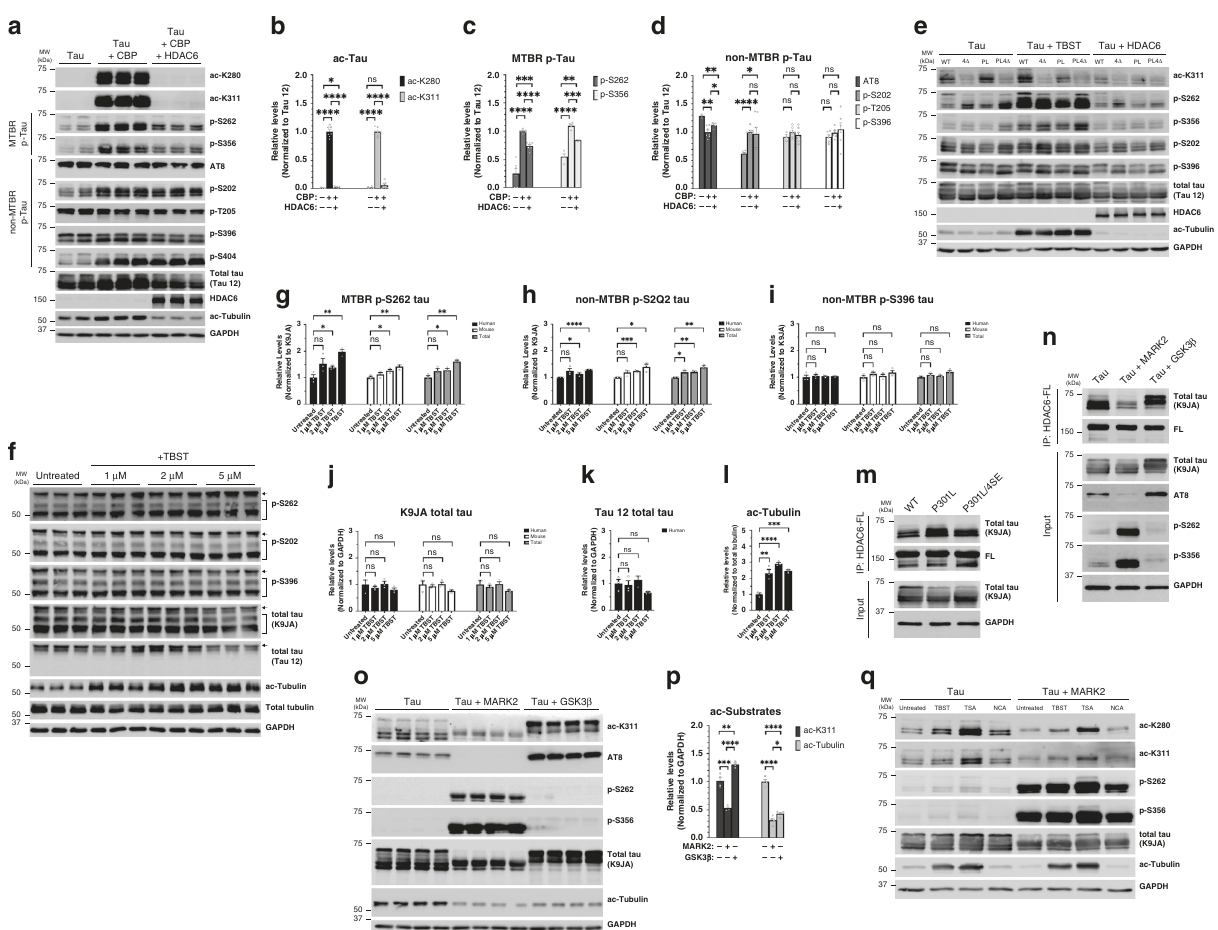
Fig. 4 The targeting of tau by HDAC6 is regulated by tau kinases. a Immunoblotting of HEK-293A cells cotransfected for 48 h with WT tau, the acetyltransferase CBP, and WT HDAC6 (where indicated) using acetylation or phosphorylation speci fi c tau antibodies. b – d The relative levels of modi fi ed tau within the MTBR (ac-280, ac-K311, p-S262, and p-S356) or outside the MTBR (AT8, p-S202, p-T205, and p-S396) were quanti fi ed by densitometry of tau PTMs normalized to total tau (Tau 12). e Cells expressing the indicated tau constructs (WT, 4 Δ , PL, and PL4 Δ ) were treated with tubastatin A (TBST) to inhibit HDAC6 or cotransfected with WT HDAC6 to suppress tau acetylation followed by immunoblotting with acetylation or phosphorylation speci fi c tau antibodies as in a . f – l Primary cortical neurons (E16) from PS19 derived tau-transgenic mice cultured for ten DIV were treated overnight with TBST at a concentration of 1 – 5 μ M and analyzed by immunoblotting followed by quanti fi cation by densitometry of tau PTMs normalized to human, mouse, or total tau (K9JA). The arrows in f highlight overexpressed human tau migrating at ~65 kDa compared to mouse tau at ~50 kDa (see also Supplementary Fig. 6c to distinguish between human and mouse tau). m Co-IP assay evaluating HDAC6 binding to WT tau, tau-P301L, and tau-P301L/4SE mutant containing S → E substitutions at all four MARK2-targeted phosphorylation sites (S262/S290/S324/S356E). Despite P301L tau showing greater binding to HDAC6, the addition of the MARK2 phosphorylation-mimic mutations reduced HDAC6 binding. n Co-IP assay evaluating tau-P301L mutant tau binding to HDAC6 in the presence of MARK2 or GSK-3 β kinases. o HEK-293A cells co-transfected with WT tau, MARK2, or GSK-3 β (where indicated) were analyzed by immunoblotting using acetylation or phosphorylation speci fi c tau antibodies followed by quanti fi cation of ac-K311 and ac-Tubulin levels normalized to GAPDH levels in p . q HEK-293A cells co-transfected with WT and MARK2 were treated with a panel of HDAC inhibitors including tubastatin A (TBST, HDAC6 inhibitor, 5 μ M), trichostatin A (TSA, class I/II HDAC inhibitor, 1 μ M) or nicotinamide (NCA, class III HDAC inhibitor, 5 mM) and analyzed as described in o . Statistical tests: p value determined by two-sided unpaired t -test from n = 6 ( b – d ), n = 3 ( g – l ), and n = 4 ( p ) biologically independent experiments. Error bars represent means± SEM ( b – d , g – l , p ). * p < 0.05; ** p < 0.01; *** p < 0.001; **** p < 0.0001. Source data are provided as a Source Data fi